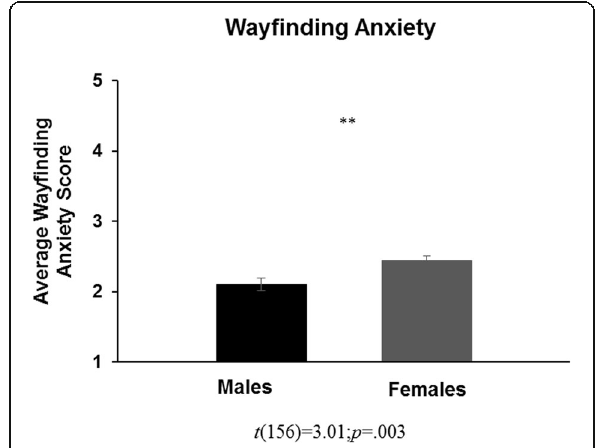
Fig. 3 Sex difference in wayfinding anxiety. ** p < .01